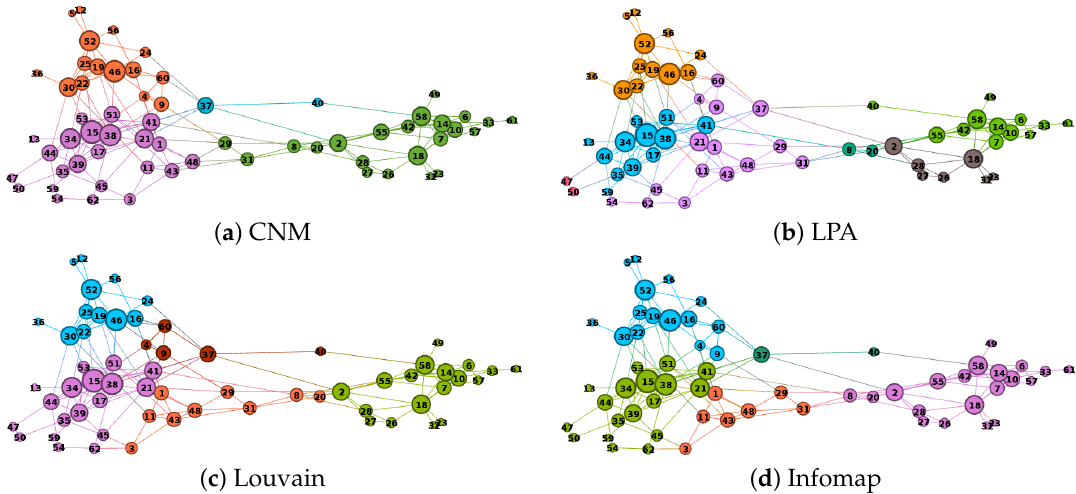
Figure 3. Comparison between different community detection algorithms on the Dolphin network.